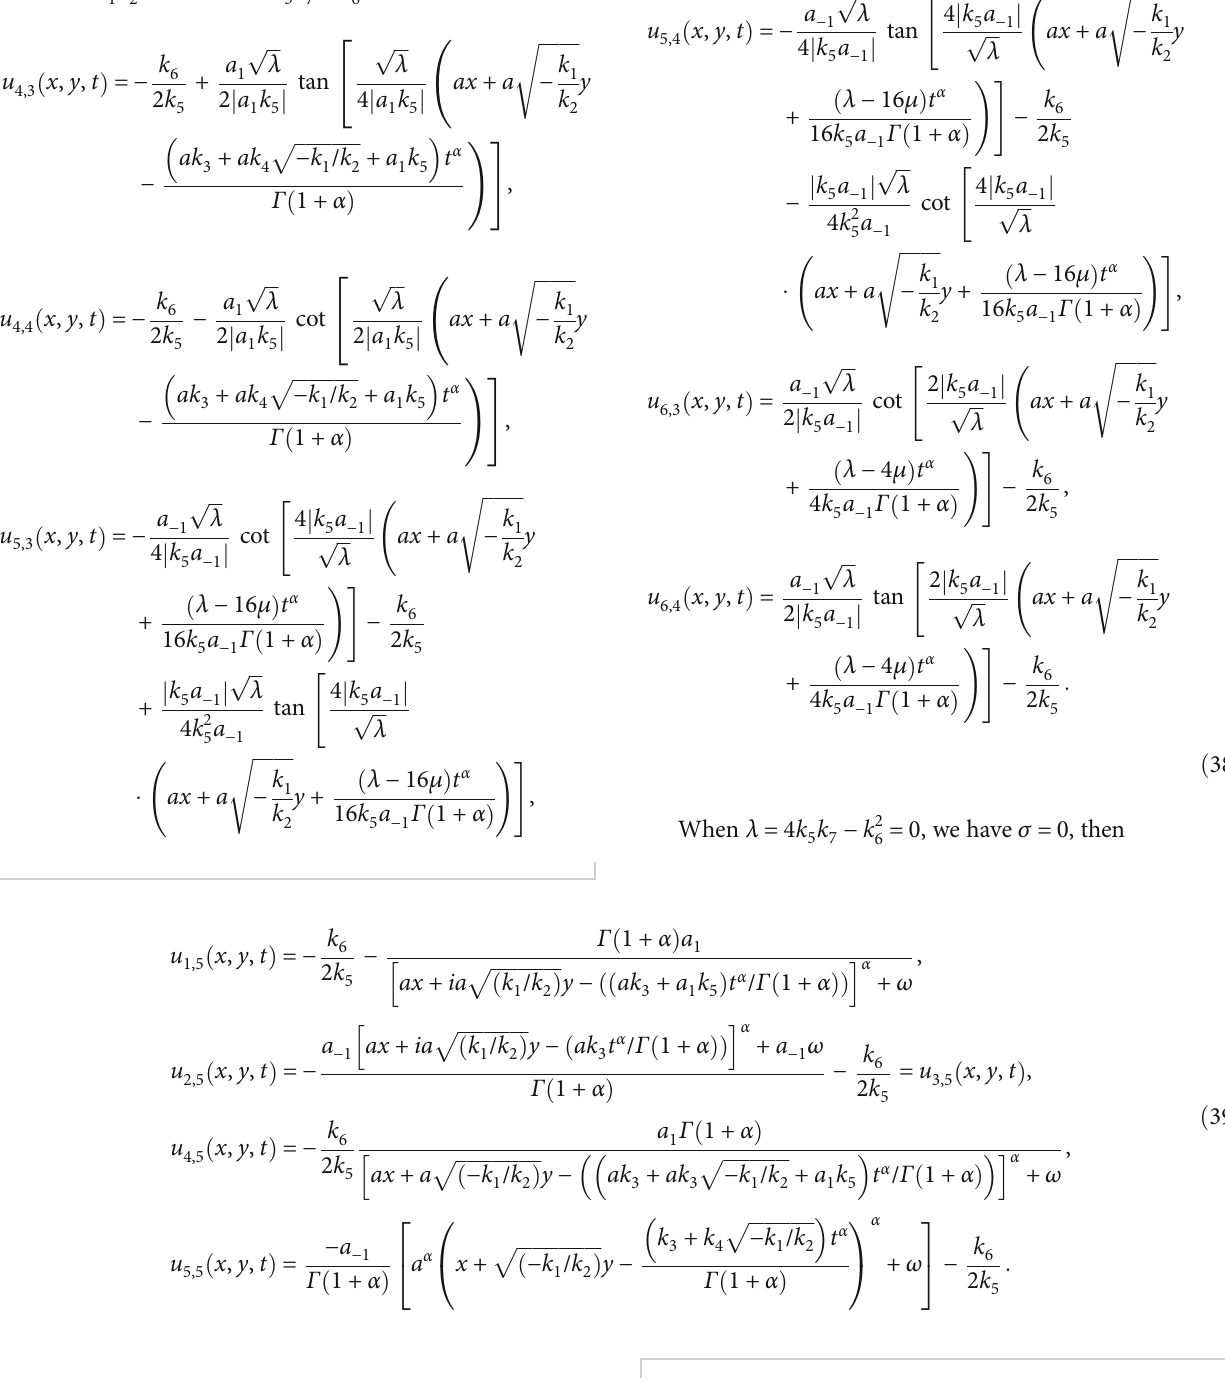
ffiffiffiffiffiffiffiffiffiffiffiffiffi p − k / k 1 2